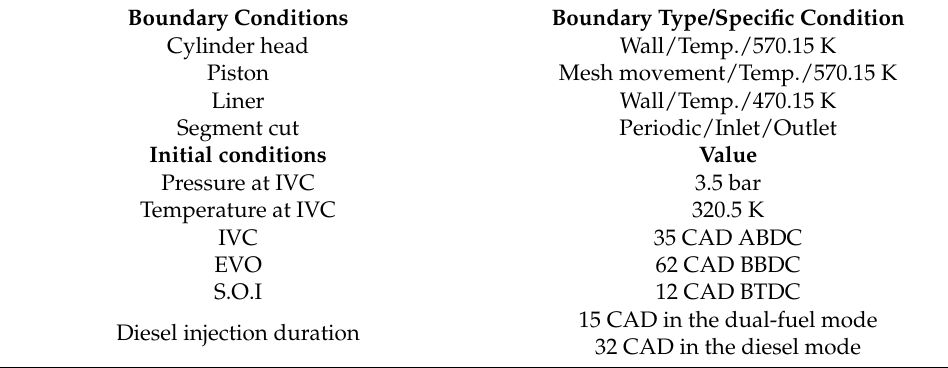
Table 3. Boundary conditions and initial conditions for the numerical simulation cases.